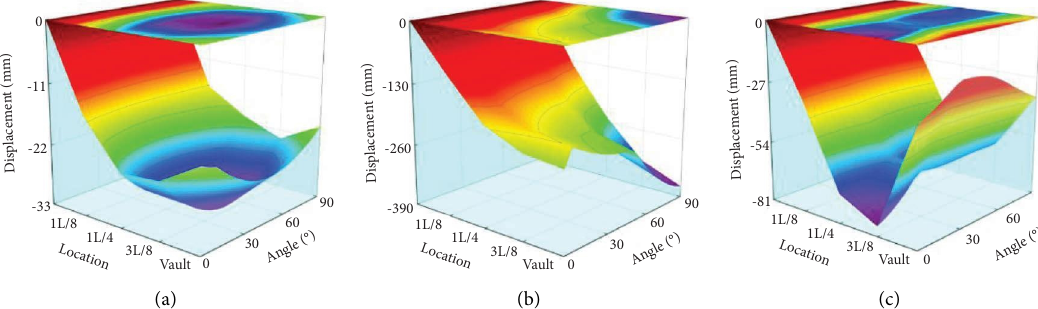
Figure 13: Upper chord displacement diagram for N min working condition under X + Y combined multiangle excitation. (a) X direction, (b) Y direction, and (c) Z direction.